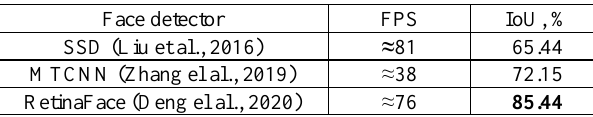
Table 5. Efficiency scores of face